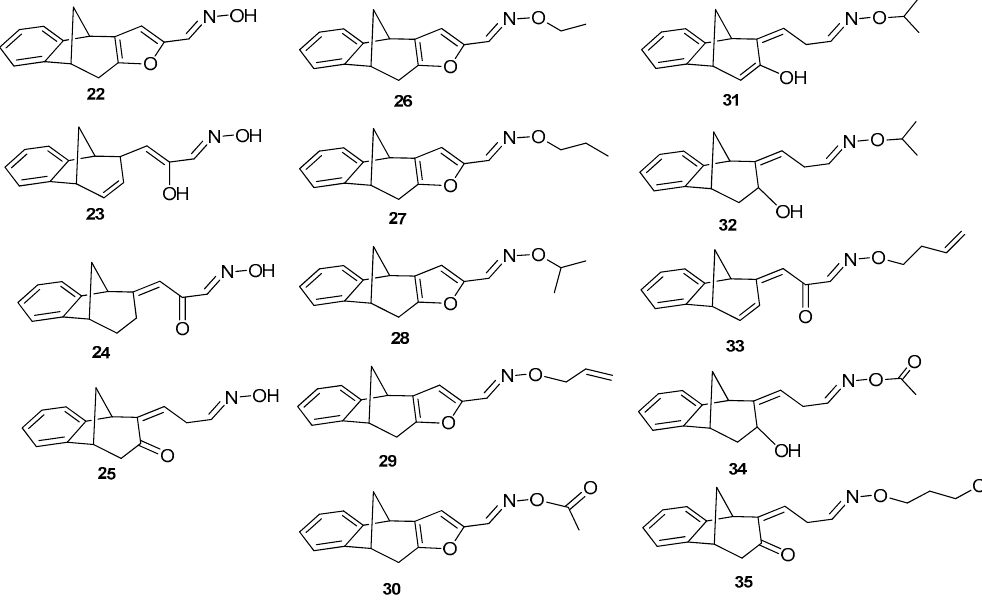
Figure 4. Obtained oximes 22 – 25 and oxime ethers 26 – 35 . Table 2. Inhibition of BChE by oximes and oxime ethers with benzobicyclo[3.2.1]-skeleton expressed as IC 50 ± SEM.